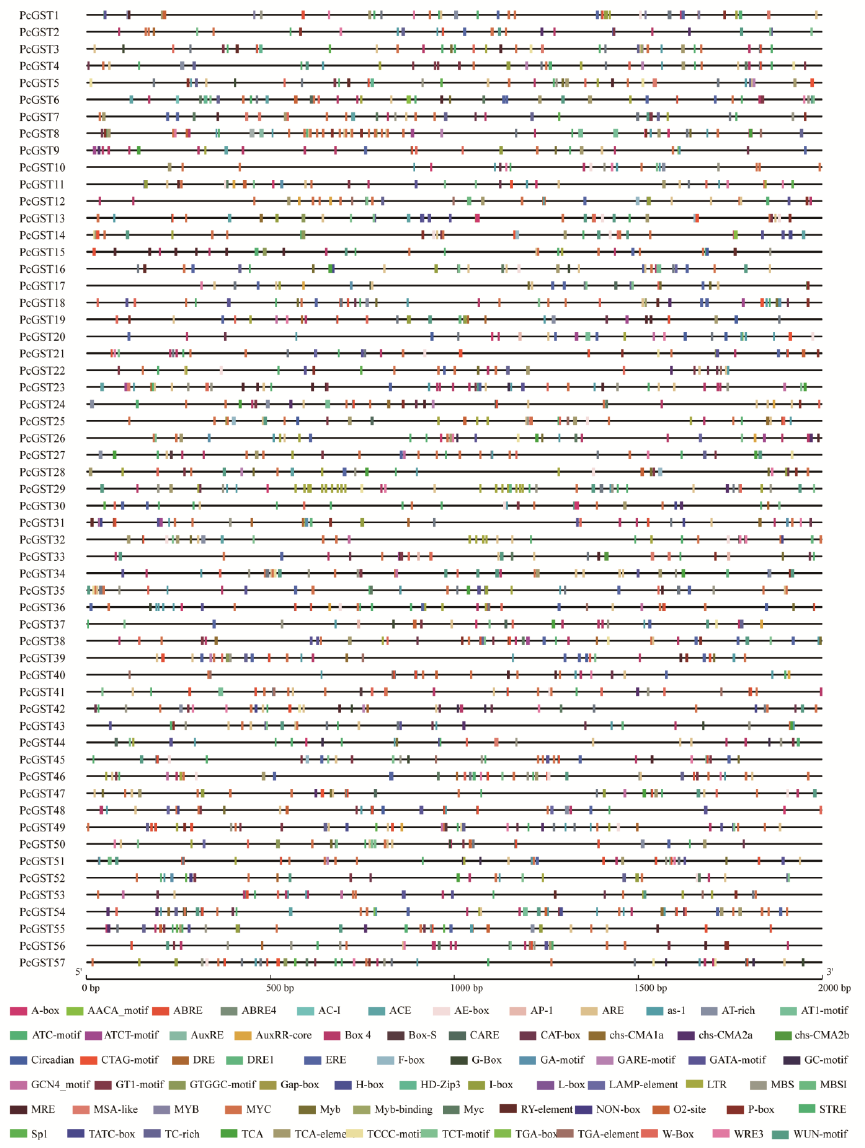
Figure 5. Cis -elements analysis in the promoter region of PcGST genes. The 2-kb of 5 (cid:48) flanking sequence upstream from the start codon was obtained for analysis, and the boxes with different colors indicated different cis